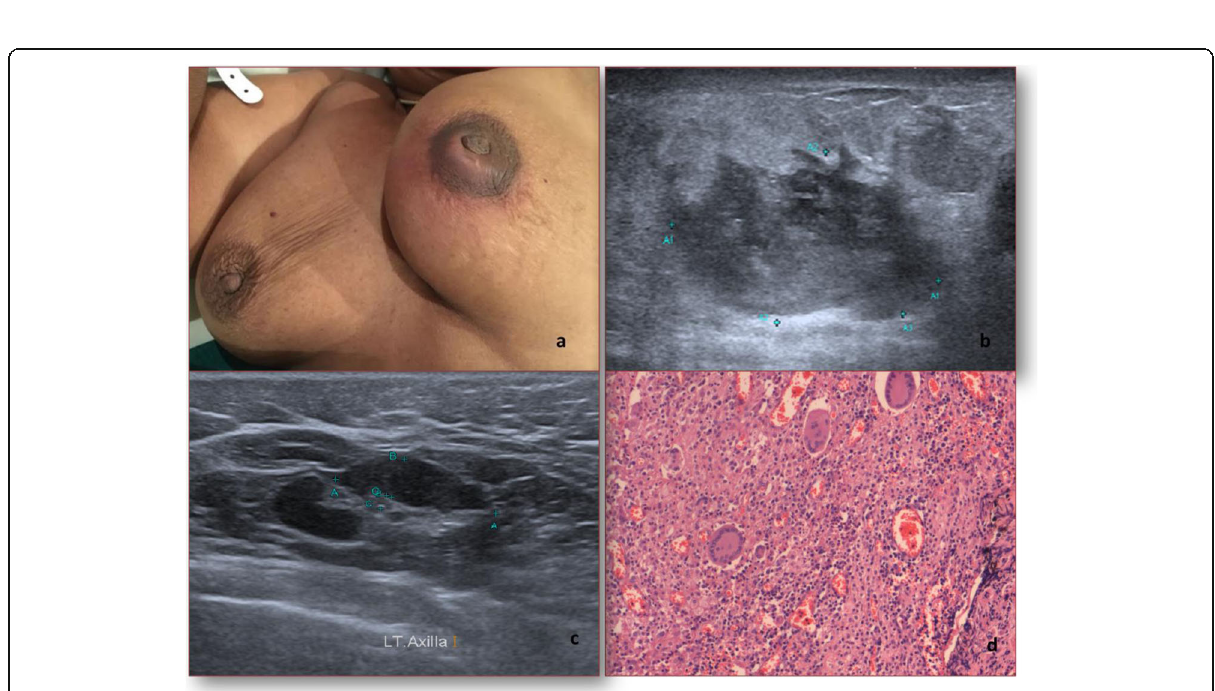
Fig. 2 A 38-year-old female diagnosed with idiopathic granulomatous mastitis, who presented with pain and swelling in the left breast. a Clinical picture showing swelling and redness in the left breast in areolar region. b Ultrasound showing irregular hypoechoic collection and inflammatory changes in surrounding breast parenchyma. c Enlarged lymph node in axilla showing irregularly thickened cortex. d Histopathology showing foreign body and Langhans type of giant cells with epithelioid cells, admixed with granulation tissue — H&E ×